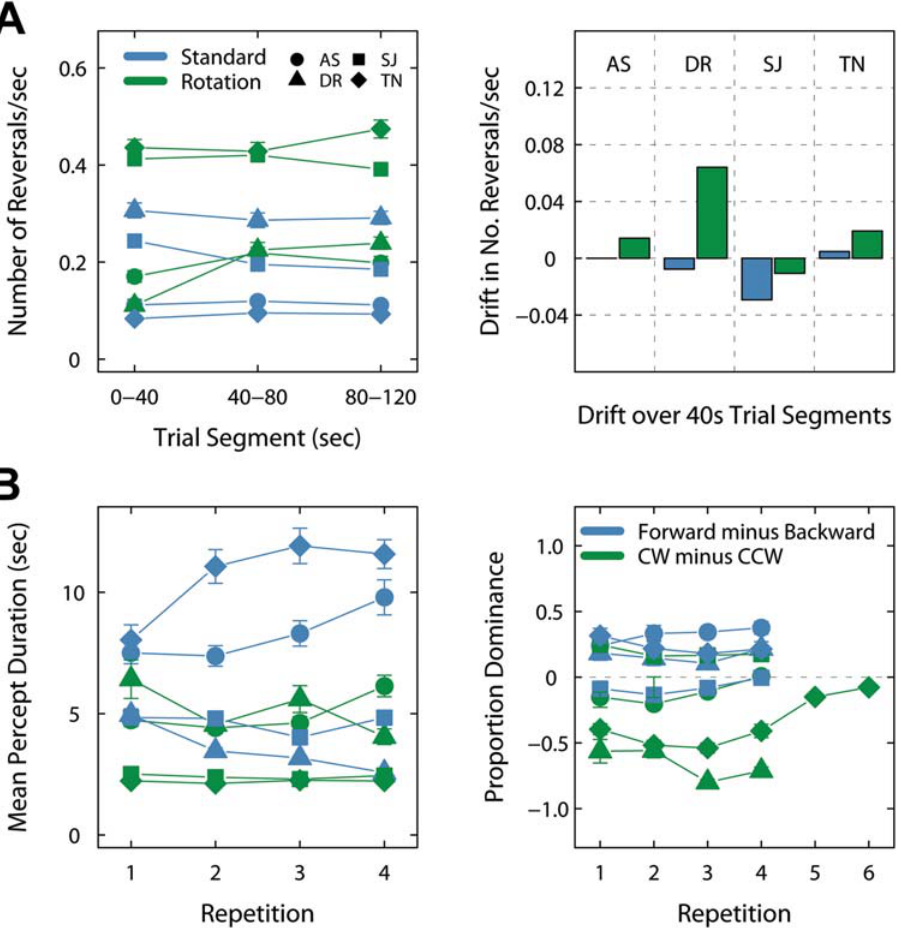
Figure 3. Experiment 2 results. (A) Reversal rates per second (left) and drift (right) across the 120 s trials, broken down into successive 40 s segments. Drift is given as the mean increase or decrease in revs/s between segments 1–2, and segments 2–3. Individual observers are represented by different symbols. Data for the standard walker (blue) and rotating walker (green) are presented separately. (B) Observers completed four repetitions of the experiment. The mean percept durations for each session (8 trials per stimulus) are plotted on the left. Proportion dominance for the different percepts across all sessions is given on the right. Positive values indicate greater dominance of the CW (rotating) or frontwards-facing (standard) percepts. We tested observer TN in an additional two sessions with the rotating walker, during which greater retention of the less dominant percept was encouraged. This resulted in a more even distribution of dominance proportions. Error bars indicate standard error